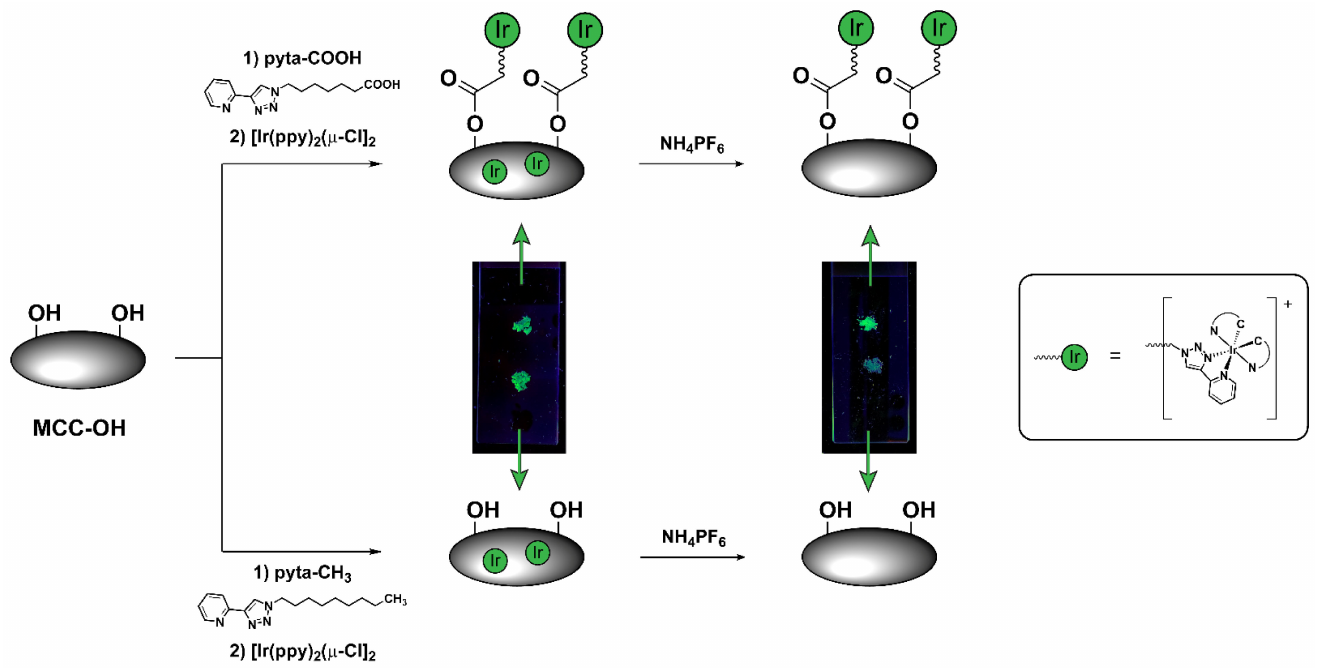
Figure 3. Electrostatic adsorption of unbound pyridyl triazole ligand and cationic cyclometalated complexes led to luminescent MCC micropowder even when treated with pyta-CH 3 , a ligand for Ir(III) that is not reactive towards MCC, as demonstrated by the digital camera pictures of MCC powders recorded under exposure to 365-nm light. However, such weak interactions are promptly disrupted by treating the powder with an electrolyte solution (5% NH 4 PF 6 in EtOH/DCM), leading to a complete loss of luminescence for the sample treated with pyta-CH 3 . On the other hand, MCC covalently bound to the pyridyl triazole ligand via esterification maintain their luminescent properties after the treatment with NH 4 PF 6 (right